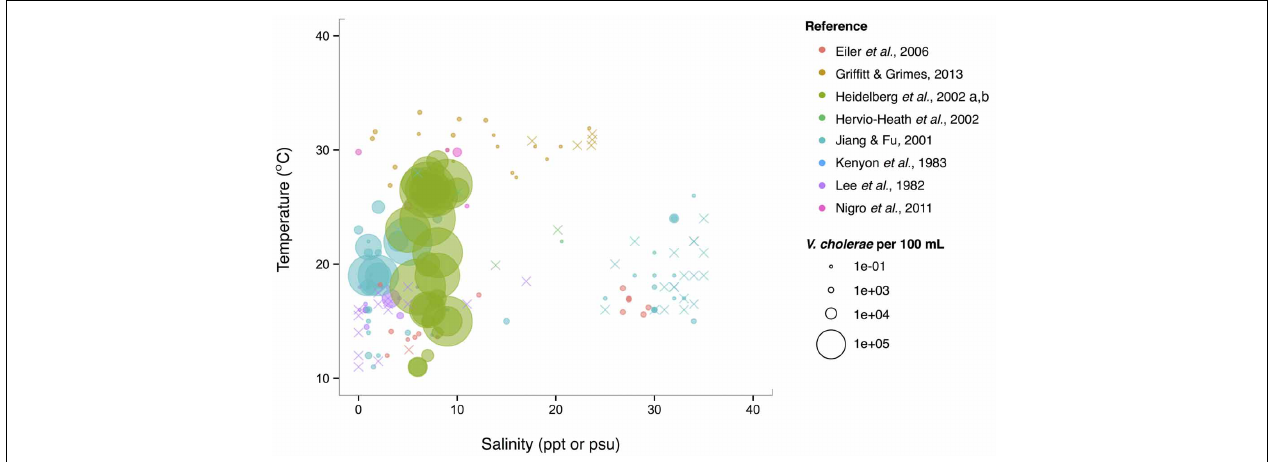
FIGURE 5 | V. cholerae favors lower salinity and occupies a broad temperature range. V. cholerae concentrations, i.e., MPN-estimated CFU or molecular marker gene copies per 100mL, reported in different studies are plotted against the temperature ( ◦ C) and salinity values (ppt or psu) at which they were found. All studies report V. cholerae ,